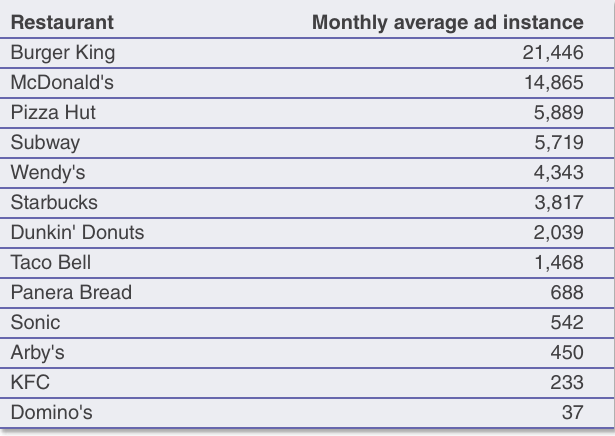
Table 33. Mobile display ad instance by restaurant